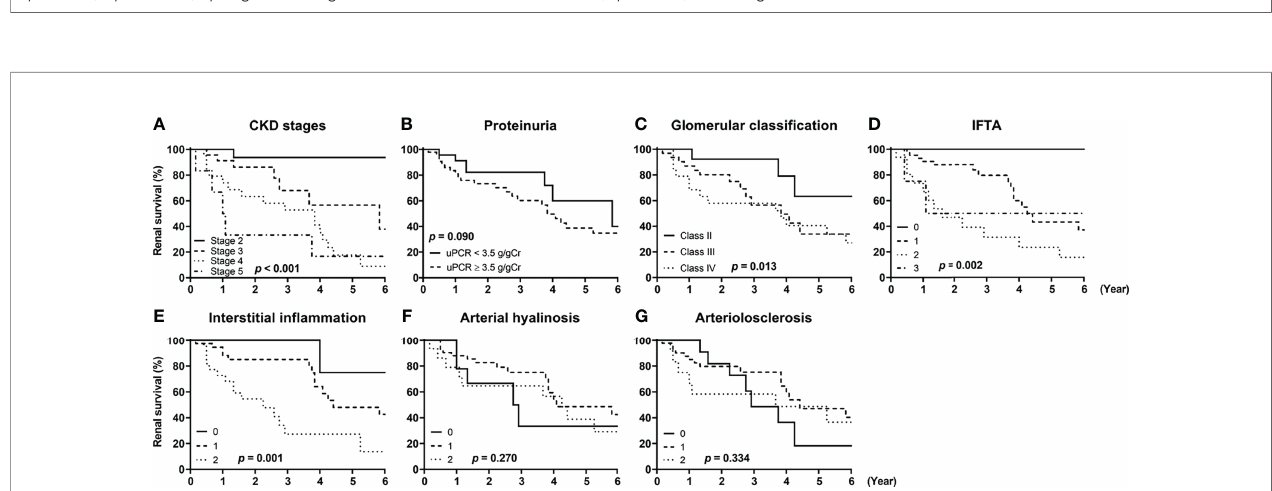
FIGURE 4 | Renal survival of patients with diabetic kidney disease according to their clinicopathologic features. The renal survival of patients with diabetic kidney disease according to (A) stages of chronic kidney disease (CKD), (B) the amount of proteinuria, (C) glomerulonephritis classi fi cation score, (D) interstitial fi brosis and tubular atrophy (IFTA) score, (E) interstitial in fl ammation score, (F) arterial hyalinosis score, and (G) arteriolosclerosis score are shown. P -values were calculated by log-rank test. CKD, chronic kidney disease; uPCR, urinary protein-to-creatinine ratio; IFTA, interstitial fi brosis and tubular